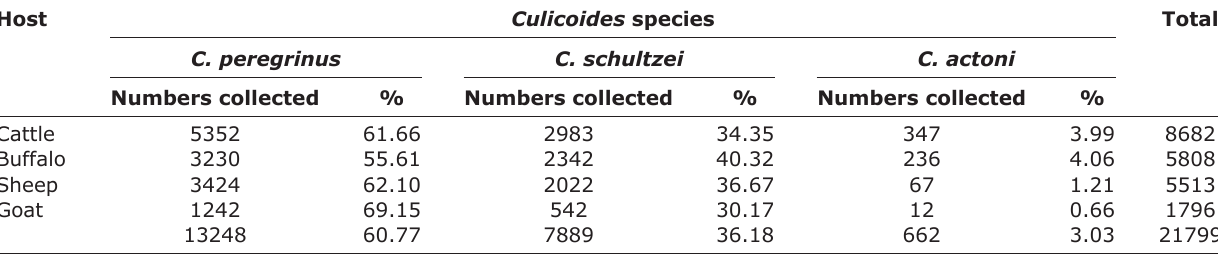
Table-5: Host midge relationship of Culicoides spp. to four species of hosts in Marathwada (Parbhani) region collected during the year 2010. Host Culicoides